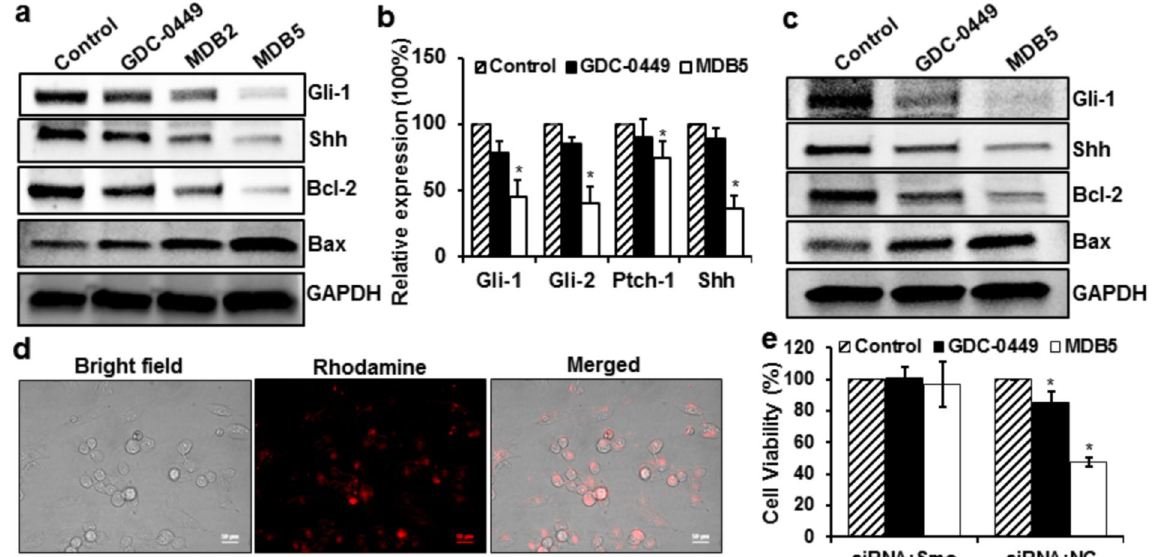
Figure 4. Effect of MDB5 on Hh pathway and target genes. ( a ) Western blot analysis for Gli-1, Shh, Bcl-2, Bax and GAPDH of MIA PaCa-2 cells treated with GDC-0449 and MDB5. ( b ) Real-time RT-PCR analysis of Gli-1, Gli-2, Ptch-1 and Shh of MIA PaCa-2 cells treated with GDC-0449 and MDB5. (c) Western blot analysis for Gli- 1, Shh, Bcl-2, Bax and GAPDH of PANC-1 cells treated with GDC-0449 and MDB5. ( d ) Transfection of labeled oligonucleotide using Lipofectamine ® RNAiMAX in MIA PaCa-2 cells. ( e ) Cell cytotoxicity assay of GDC-0449 and MDB5 in Smo knockdown MIA PaCa-2 cells. Percentage of viable MIA PaCa-2 cells was estimated by MTT assay. Data is shown as mean ± SD of three separate experiments (Student t-test; * p < 0.05 ; n = 3 ). Cropped Western blots are shown. Full-length Western blots are included in the Supplementary Information (Fig. S14).